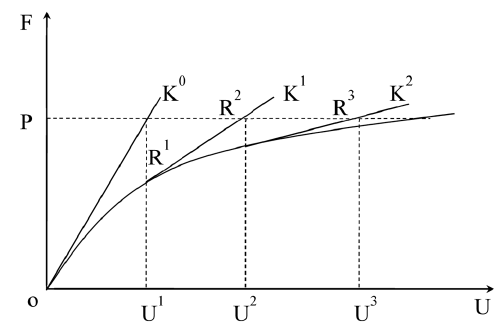
Fig. 4. Effects of geometric nonlinearity